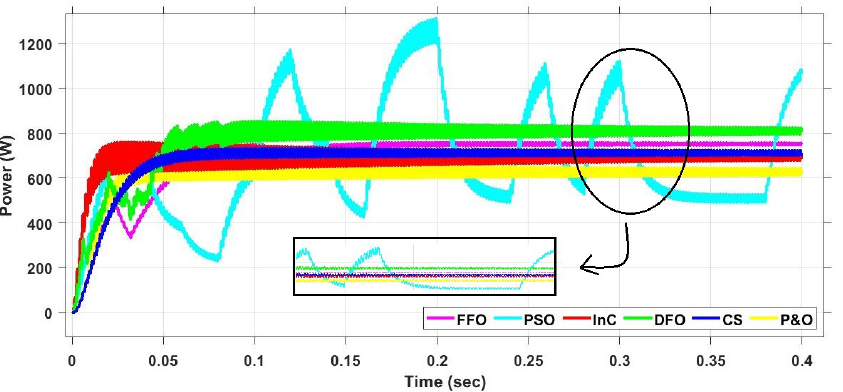
Figure 22. UI power comparison between all algorithms for centralized PV system.